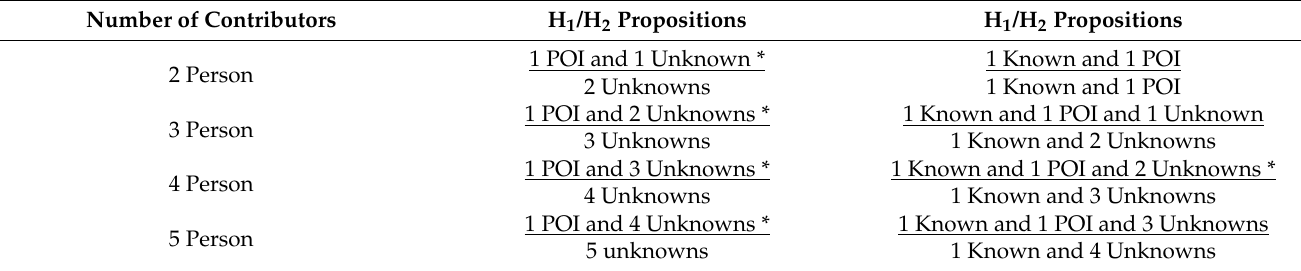
Table 3. Summary of the propositions tested for each mixture type with the MaSTR™ software. In MaSTR™, the person of interest (POI) genotype is defined as a “reference” and additional unknown genotypes are defined as “alternates”. MaSTR™ would not calculate an absolute exclusion (LR = 0) for a defined contributor; it assigned LR values < 1 with no lower limit for true